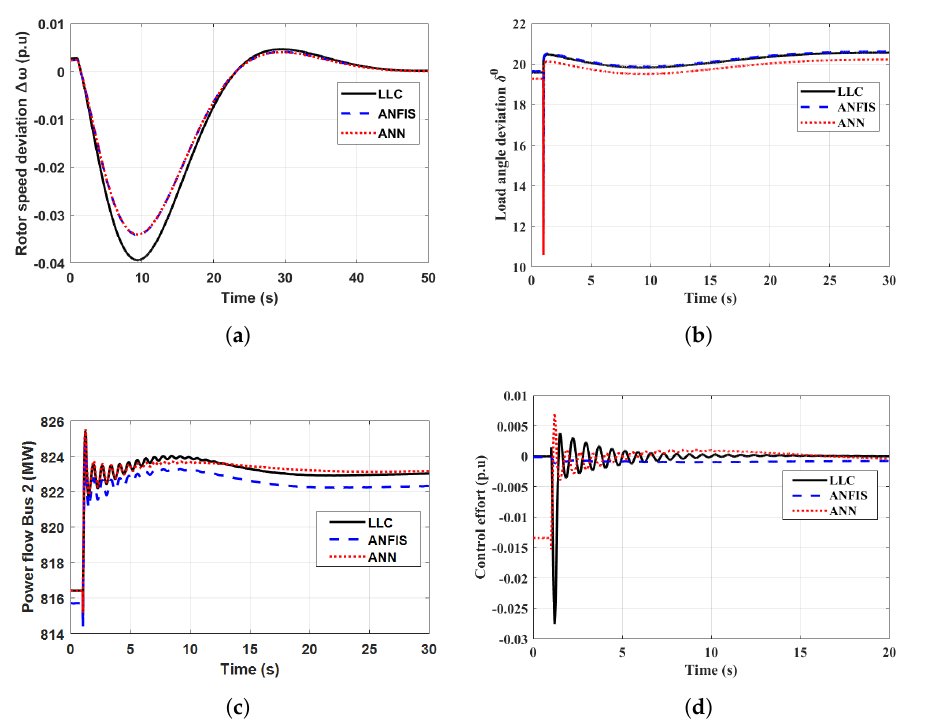
Figure 11. Case 3: Two-area power system under heavy load variation. ( a ) Rotor speed deviation. ( b ) Load angle deviation. ( c ) Flow of power through the line 2. ( d ) control effort.